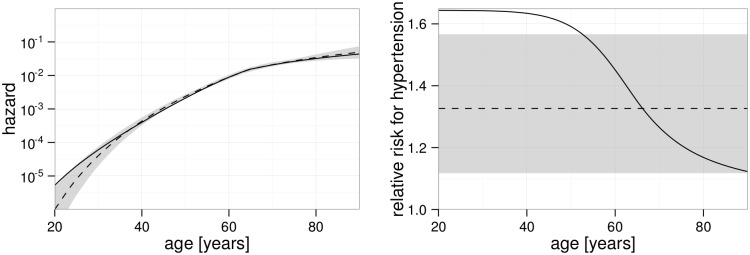
Age dependent hazard and relative risk of hypertension.In both panels, the solid line refers to the mechanistic model while the empirical model is shown by a dashed line and with 95% confidence interval indicated in gray. The plots refer to a worker born in 1930, smoking and without higher education. A: Hazard of a worker with normal blood pressure. The kink after age 60 is related to a calendar year effect around the time of the transition from the Soviet Union to Russia. B: Ratio of the hazard of a worker with hypertension compared to the hazard of a worker with normal blood pressure.